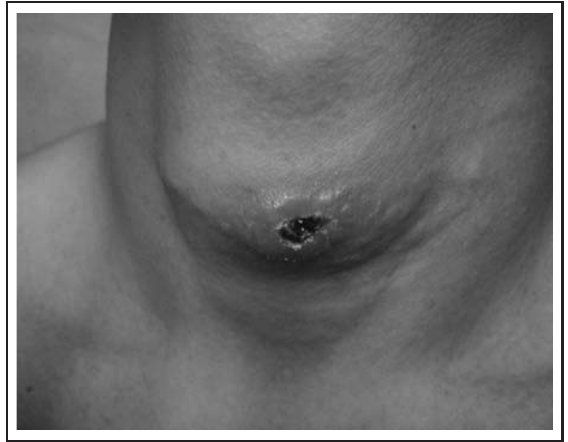
Figure 3. FNAC smear, Papanicolaou stain, 40x; an epithelioid granuloma containing numerous amas- tigote of Leishmania within histiocytes. Background